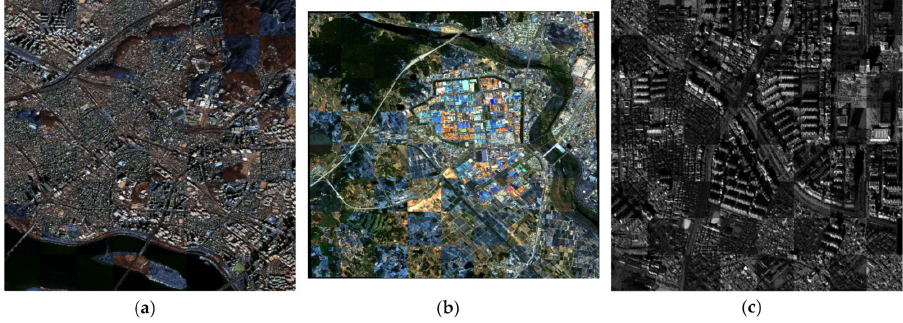
Figure 7. Results of warping using improved piecewise linear (IPL) transformation from the real dataset: ( a ) First site, ( b ) second site, and ( c ) third site.